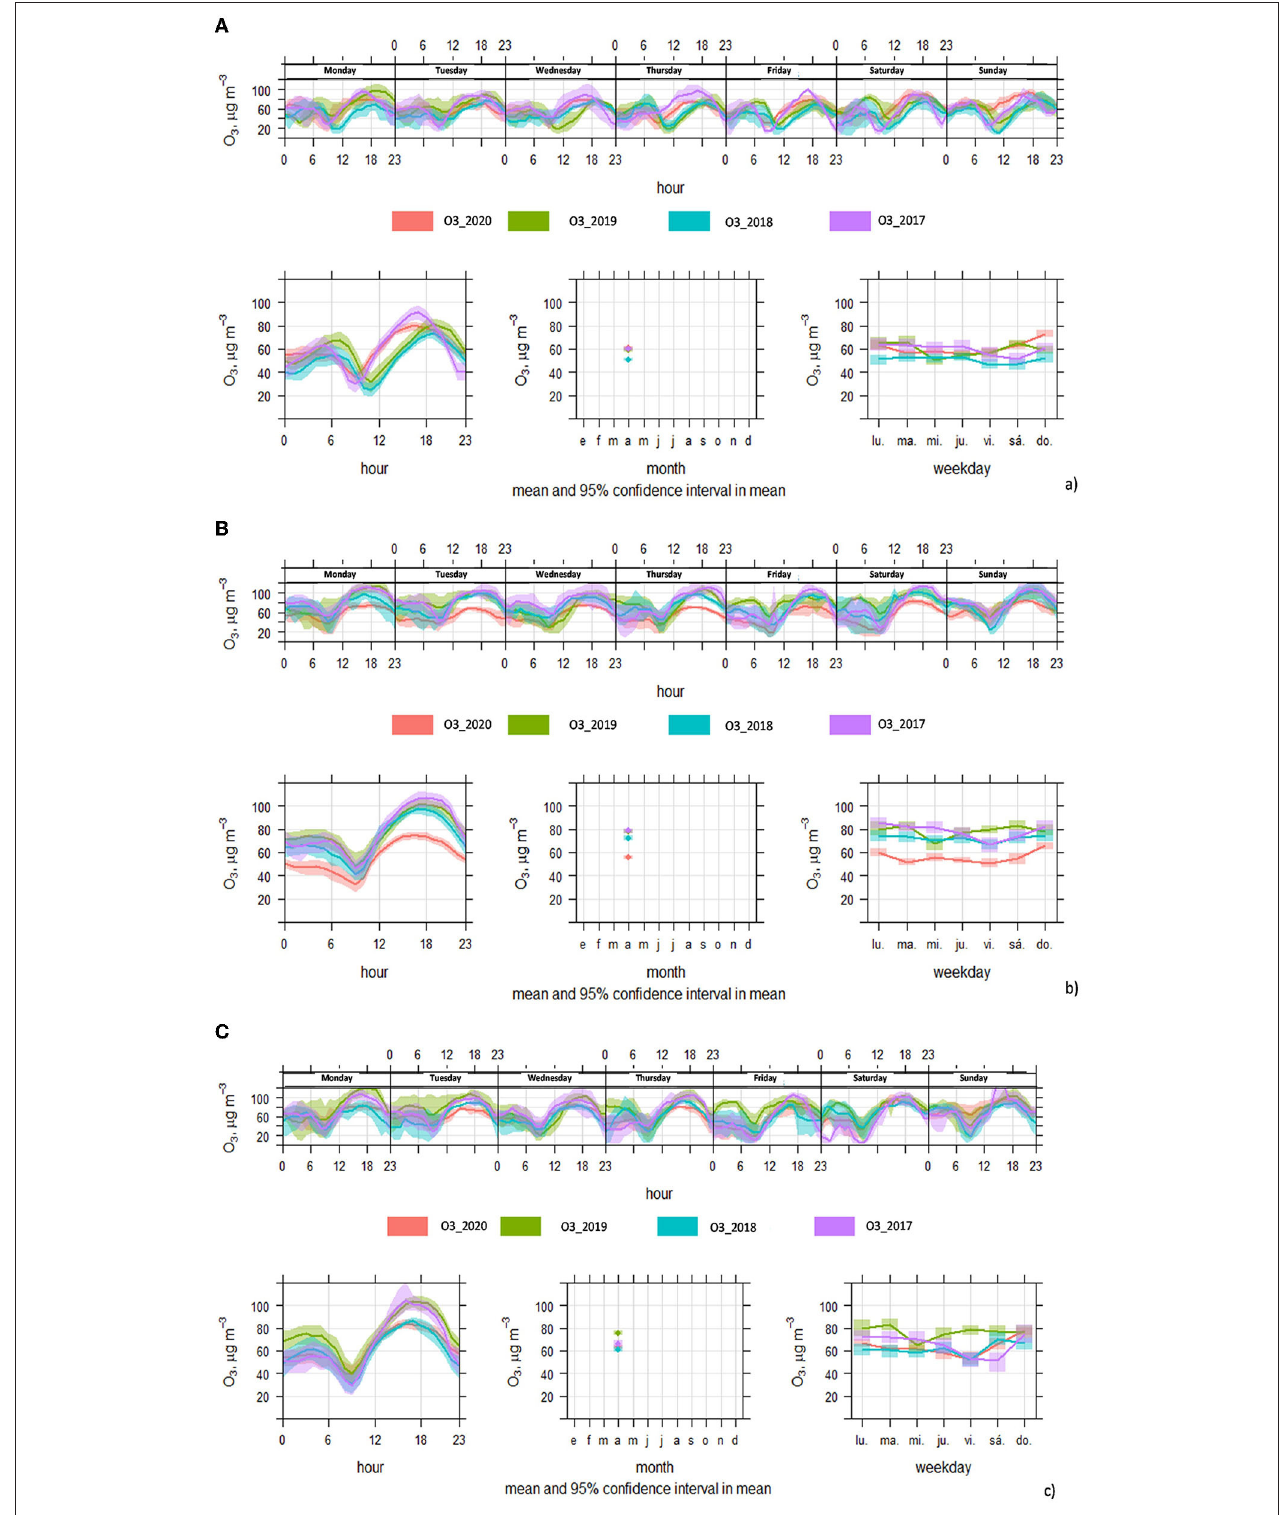
FIGURE 2 | The O 3 time series for the consecutive months of April for three air quality station (AQS) representatives of each category: (A) Escuelas Aguirre: traffic, (B) Casa de Campo: suburban, and (C) Farolillo: background. The figure was made using the function timeVariation from the OpenAir R package (Carslaw and Ropkins,